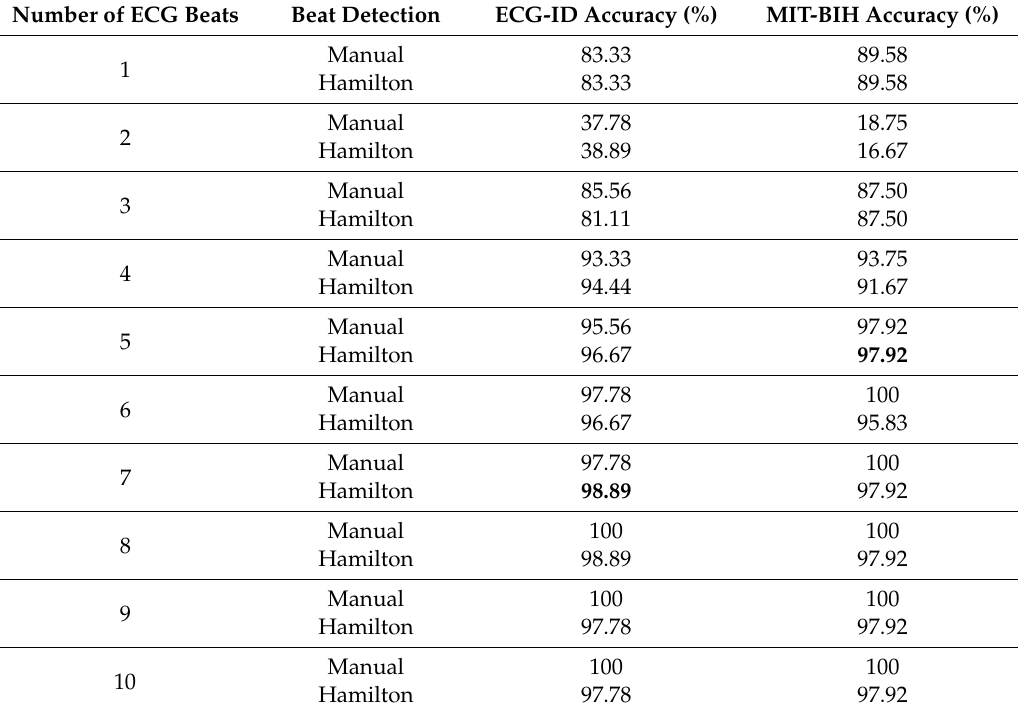
Table 5. Experiment results of a various number of ECG